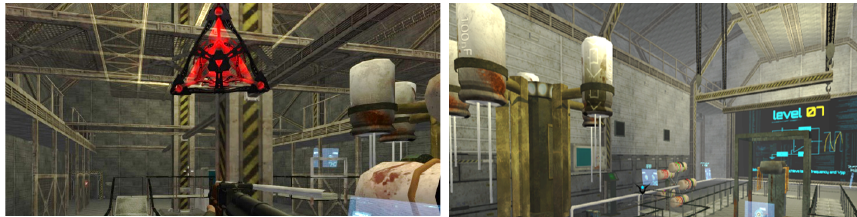
Fig. 10. Base security system (sentinels) and oscillator circuit